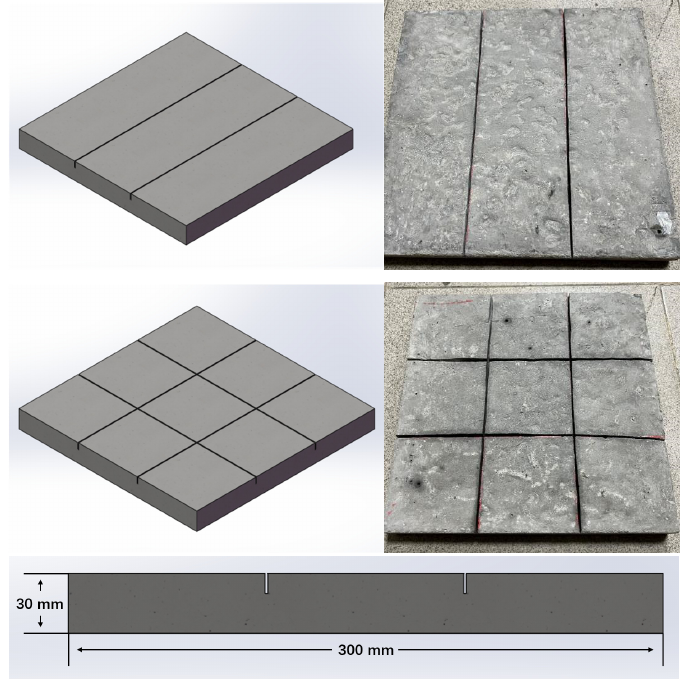
Figure 2. Three-dimensional (3D) view and front view of PCC slabs.